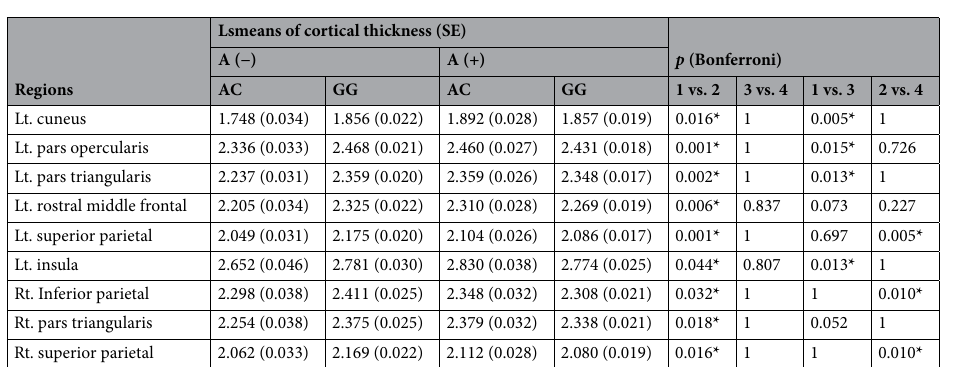
Table 4. Lsmeans of cortical thickness in the four groups and among-group comparisons in each brain region. Lsmeans, Least-Squares means; SE, Standard errors. We marked * for p value below 0.05 after Bonferroni